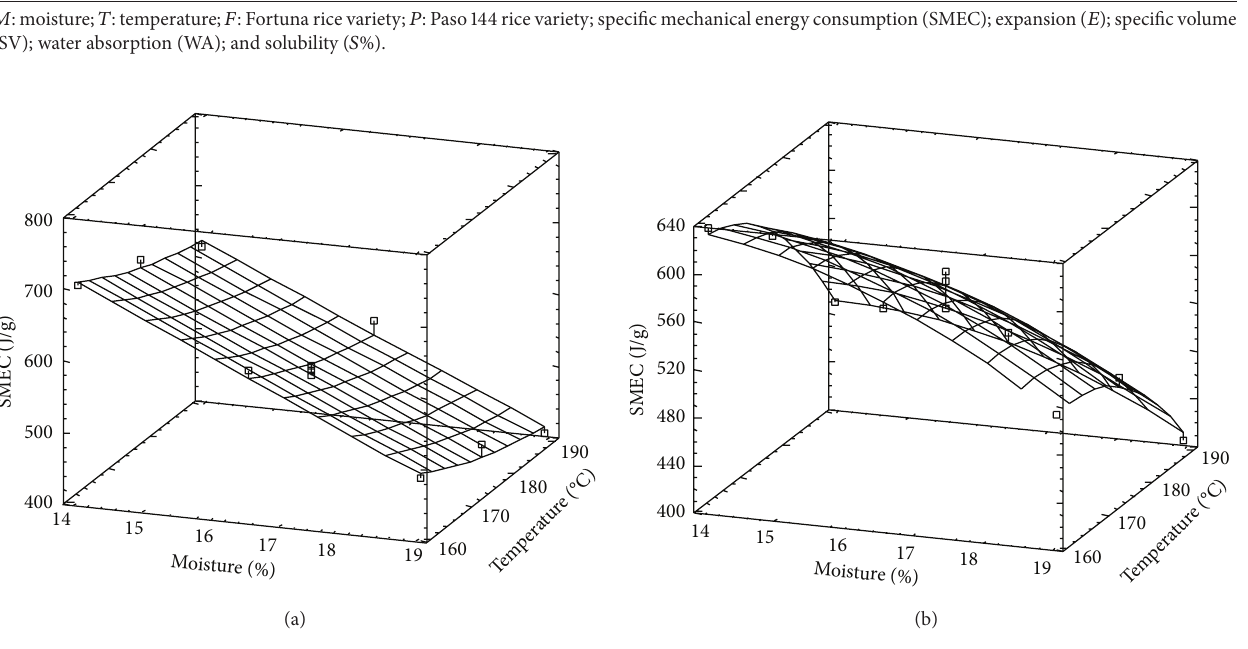
Figure 1: Surface response for SMEC corresponding to Fortuna rice variety (a) and Paso 144 rice variety (b).